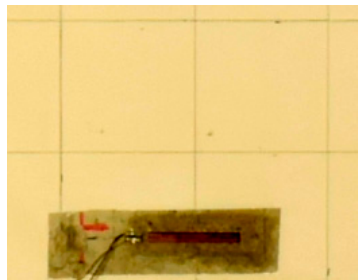
Figure 15. Example of a surface finishing detail on beam #1.